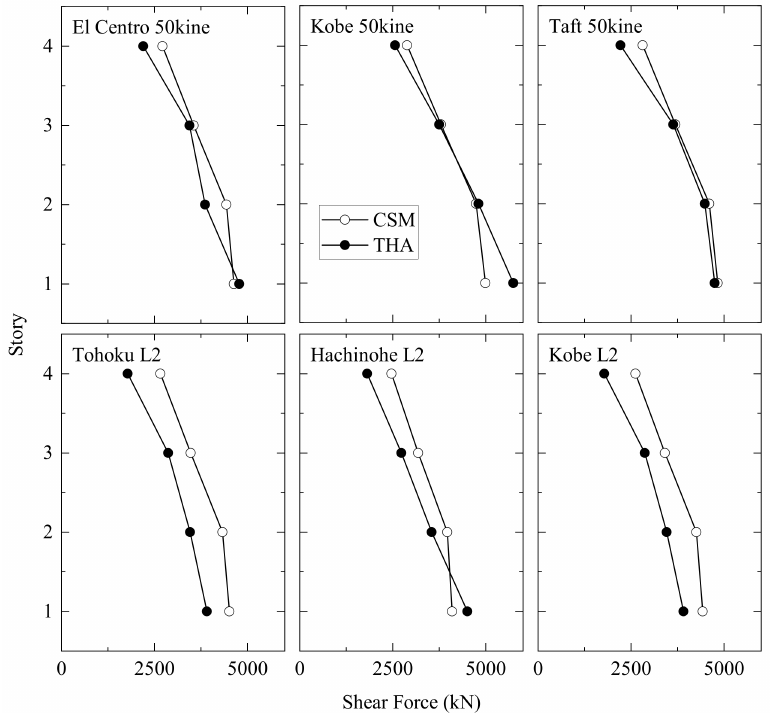
Figure 12. Comparison of story shear forces between proposed CSM and THA for 4-story building.